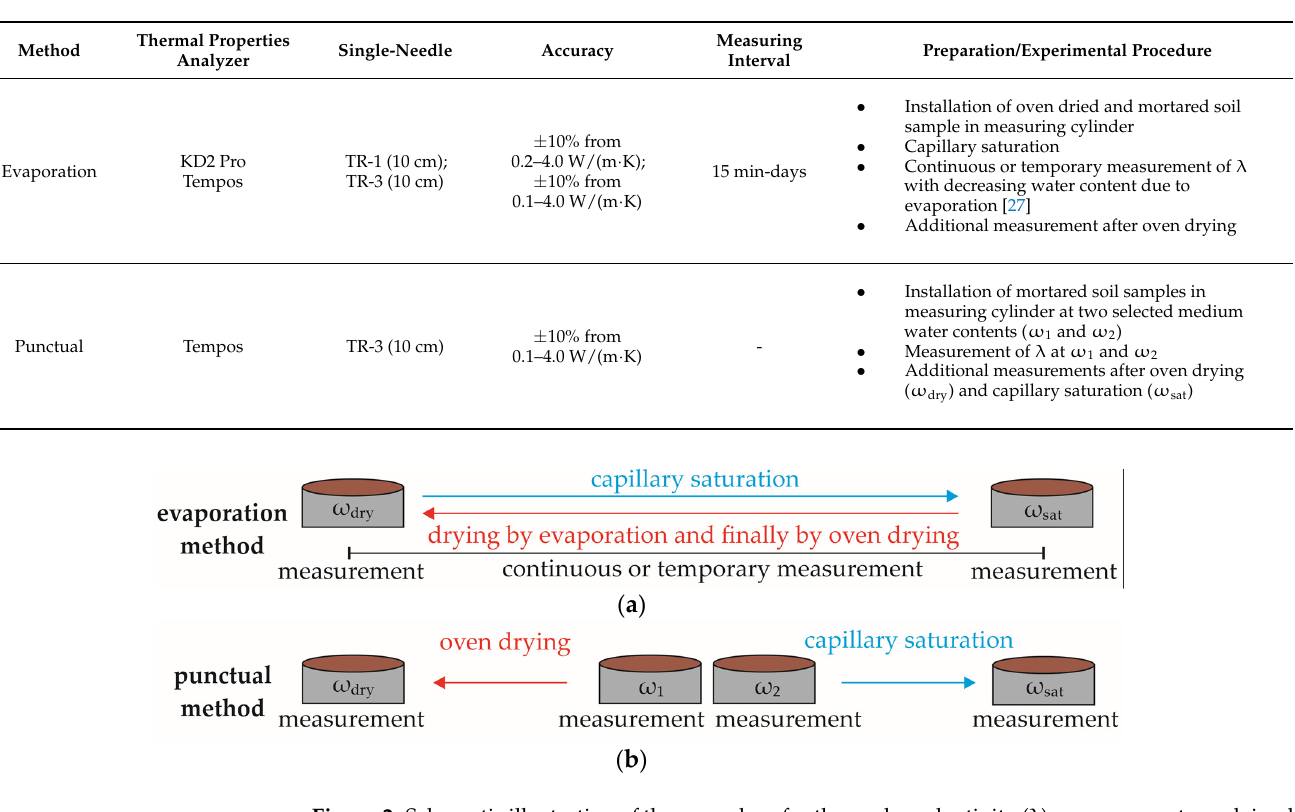
Table 2. Measurement devices and approaches for thermal conductivity ( λ ) measurements with single-needle sensors on fine-grained, repacked soil samples. Thermal properties analyzer KD2Pro by Decagon Devices, Inc. and Tempos by METER Group, Inc.